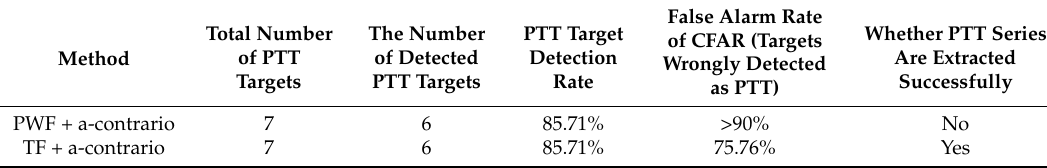
Figure 12. ( a ) filtered image based on TF analysis; ( b ) point-like target detection results; ( c ) a-contrario extraction result; and ( d ) extraction results marked on the original image. Table 4. Results comparison of two methods in Experiment II.